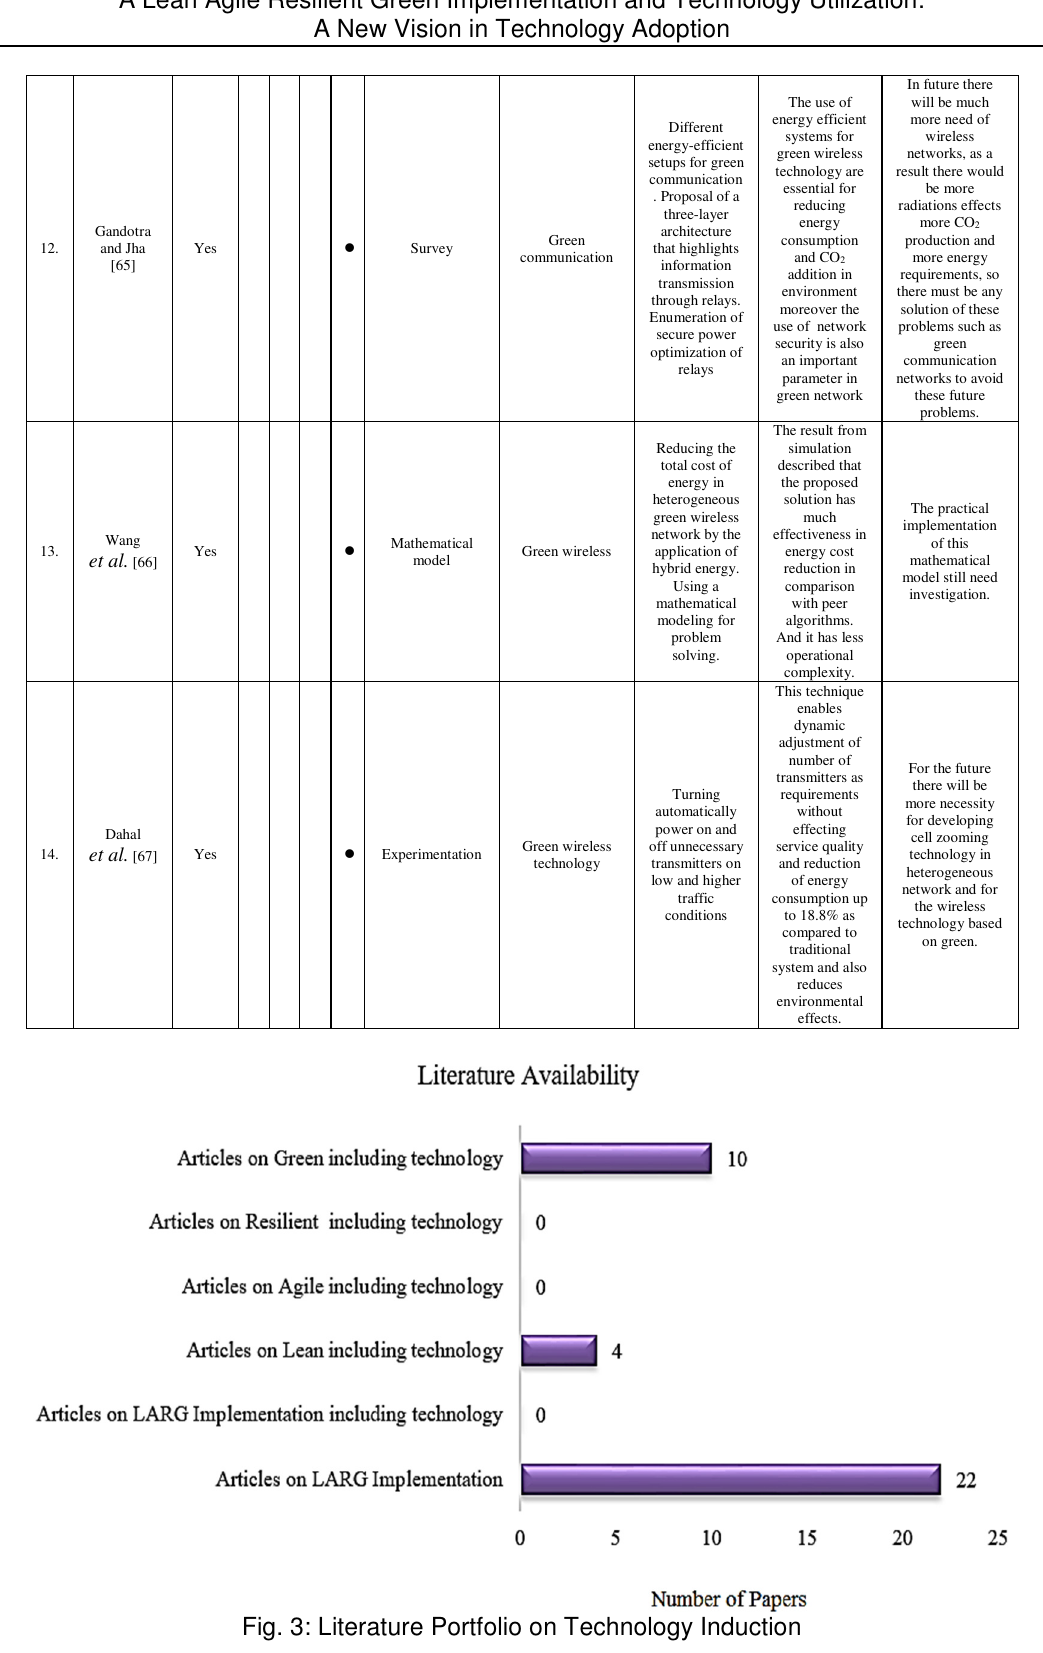
Fig. 3: Literature Portfolio on Technology